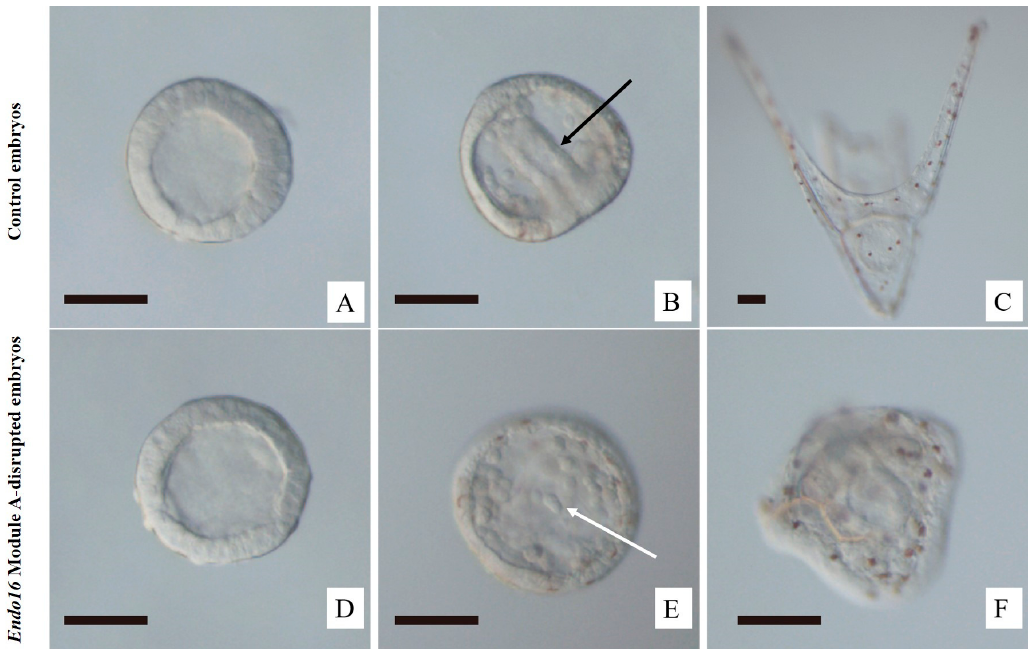
Figure 2. Effect of disruption of Endo16 cis-regulatory elements on the development of L. variegatus . In the blastula stage, there is no difference between embryos injected with gRNAs ( A ) and control embryos ( D ). In the gastrula stage, embryos injected with gRNAs failed to undergo gastrulation ( E ) compared to control embryos ( B ). In the pluteus stage, embryos injected with gRNAs displayed morphological abnormalities and failed to develop into four-arm pluteus larvae with a functional gut ( F ) compared with control embryos ( C ). Black arrow indicates the normally developing gastrum and white arrow indicates disorganized cells in the blastocoel. Scale bar (black line) = 100 μ m. Table 2. Phenotypic ratios of embryos injected with Cas9 mRNA (258.72 ng/ μ L) and gRNAs scored at the gastrula stage.